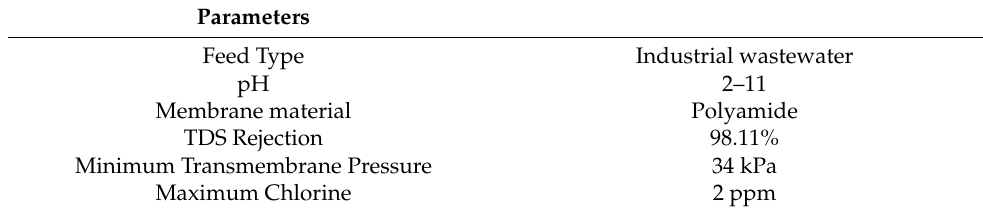
Table 4. RO membrane specification [16].